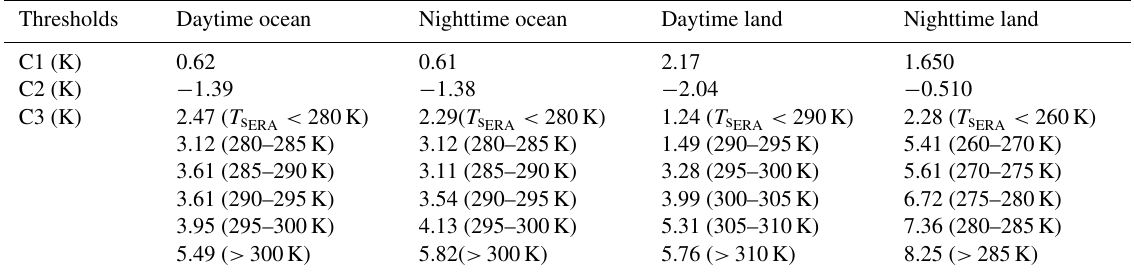
Table 1. Threshold values used in the clear-sky tests. Details of threshold definitions and the ways to determine them can be found in Sect. 3.1.